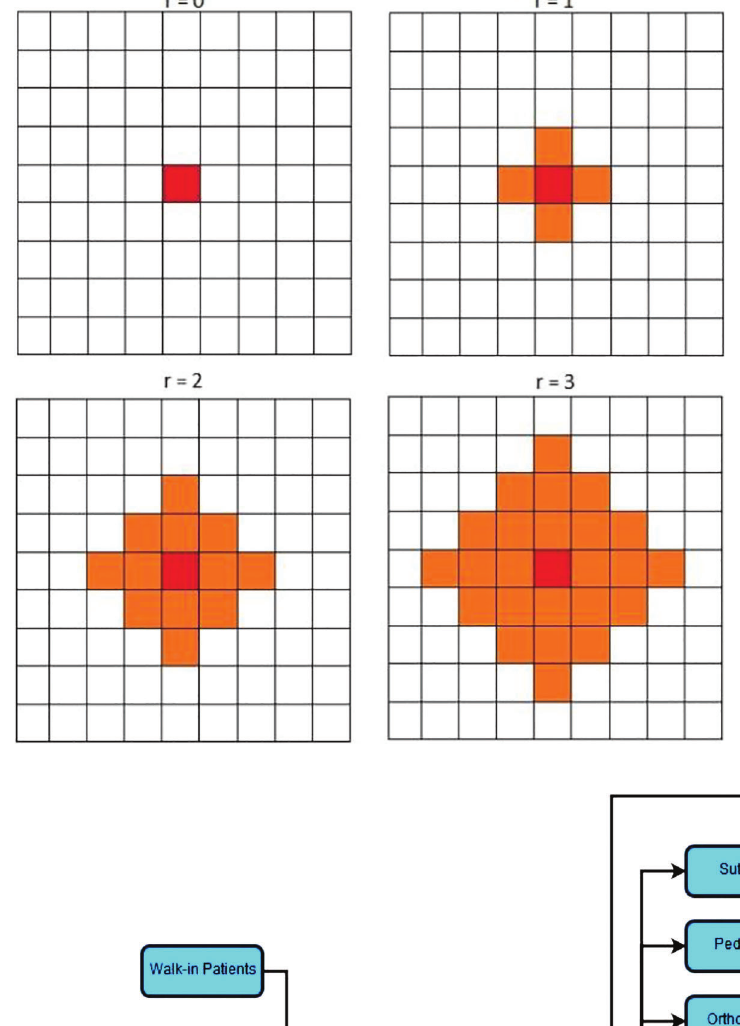
Figure 7. Neumann neighborhood for r =0, r=1, r=2, and r=3. r: range.